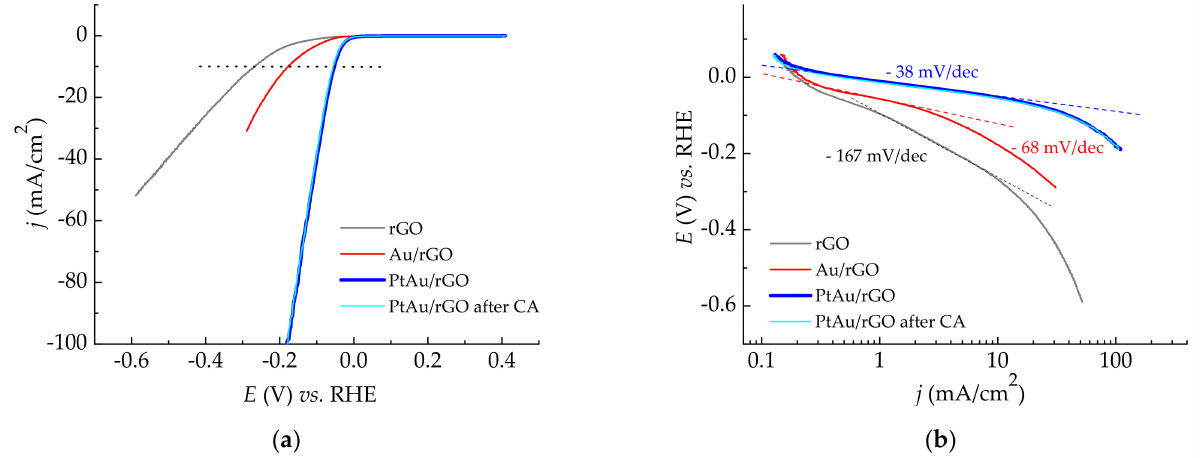
Figure 6. Hydrogen evolution reaction in 0.5 M H 2 SO 4 : ( a ) LSV curves recorded at a scan rate of 10 mV/s for rGO, Au/rGO, and PtAu/rGO electrodes, as well as for PtAu/rGO alone after stability test; ( b ) Derived Tafel